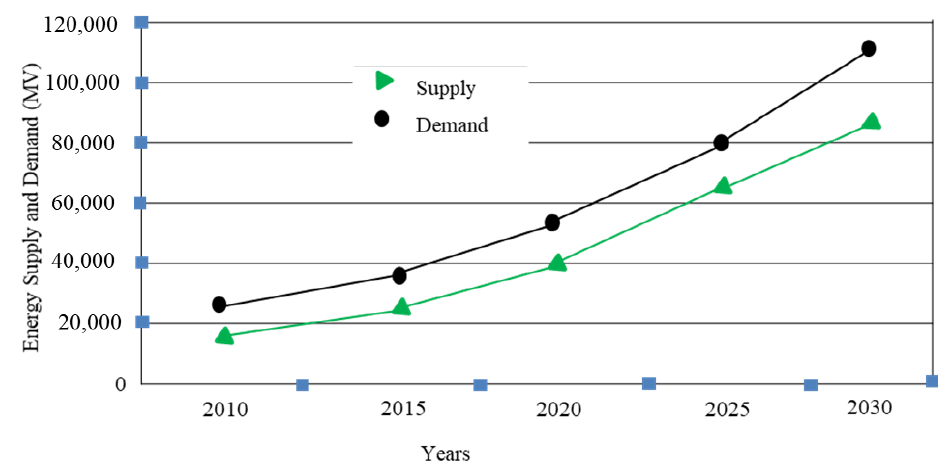
Figure 5. Supply and Demand of Pakistan: 2010–2030 [60].